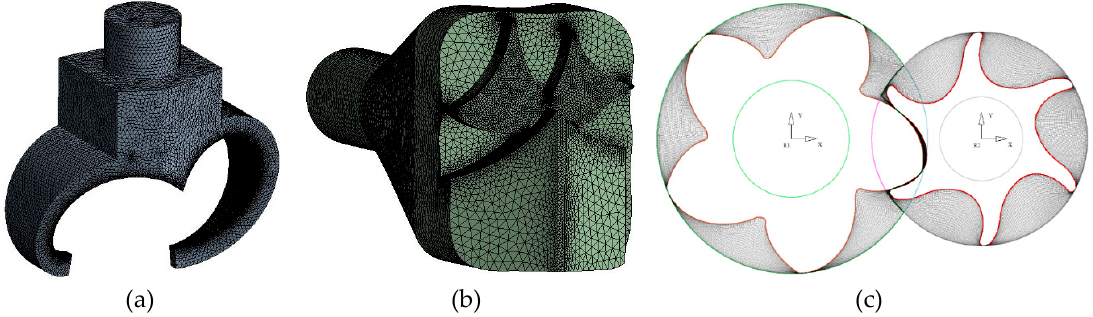
Figure 2. Meshing of different fluid domains. ( a ) Suction port fluid domain grid. ( b ) Discharge port fluid domain grid, ( c ) Two-dimensional mesh of volumetric element.